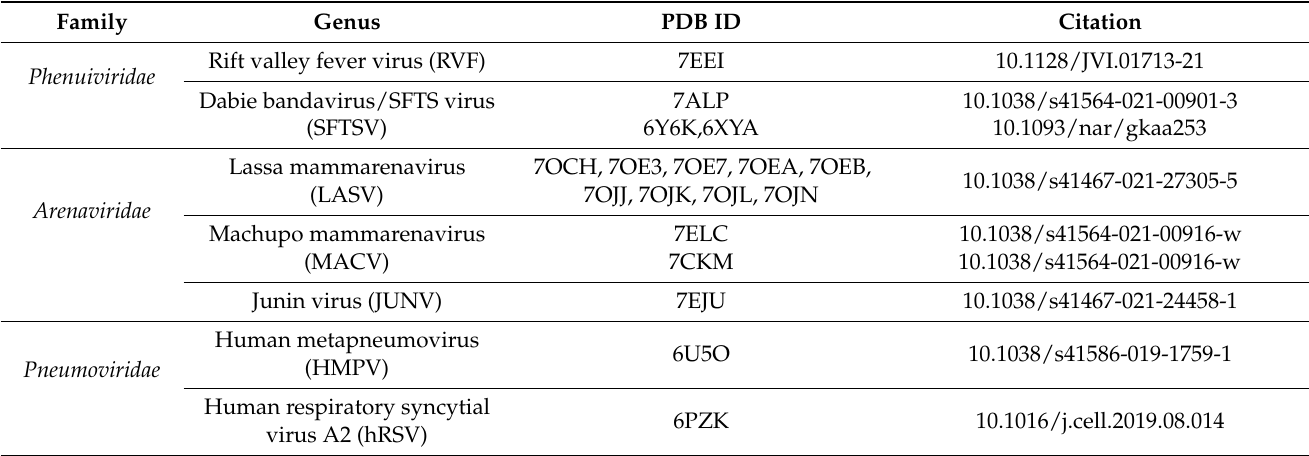
Table 1. Recent structures of viral RNA-dependent RNA polymerases